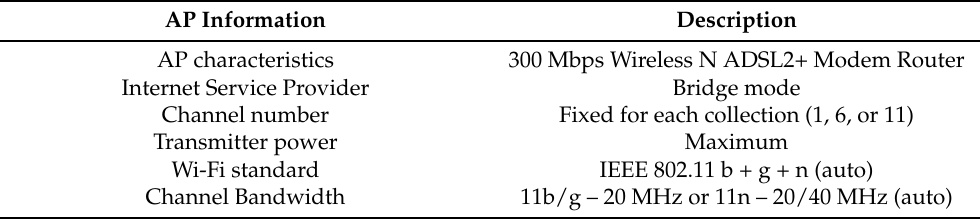
Table 2. Access Point